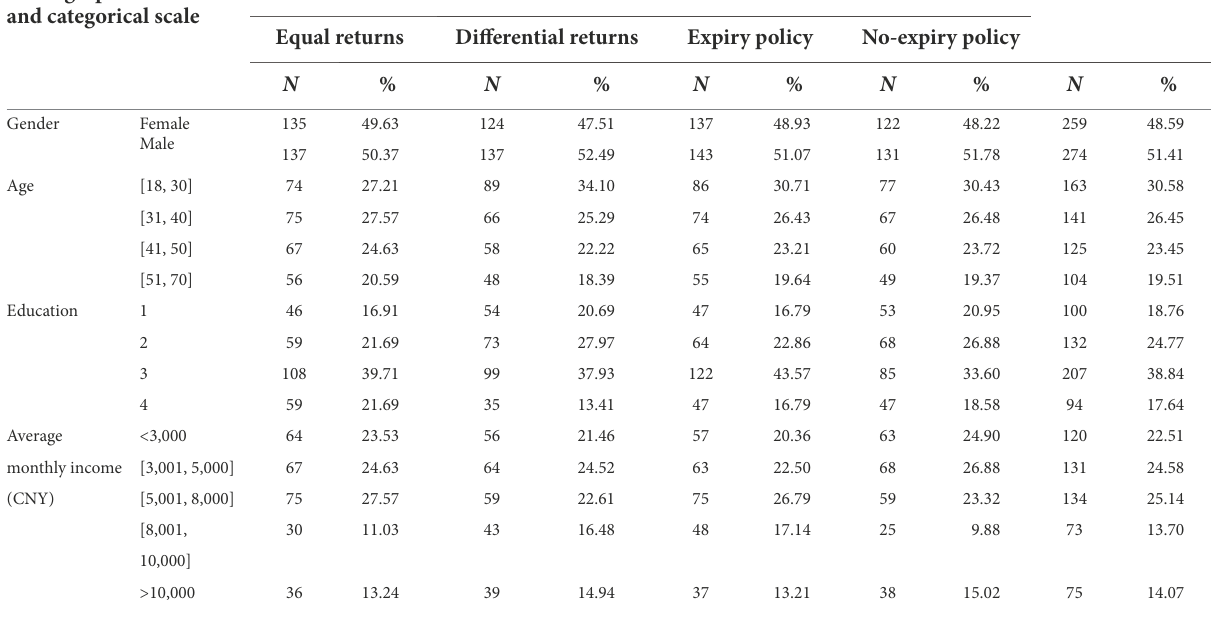
TABLE 3 The socio-demographic profiles of the respondents. Demographic factors and categorical scale